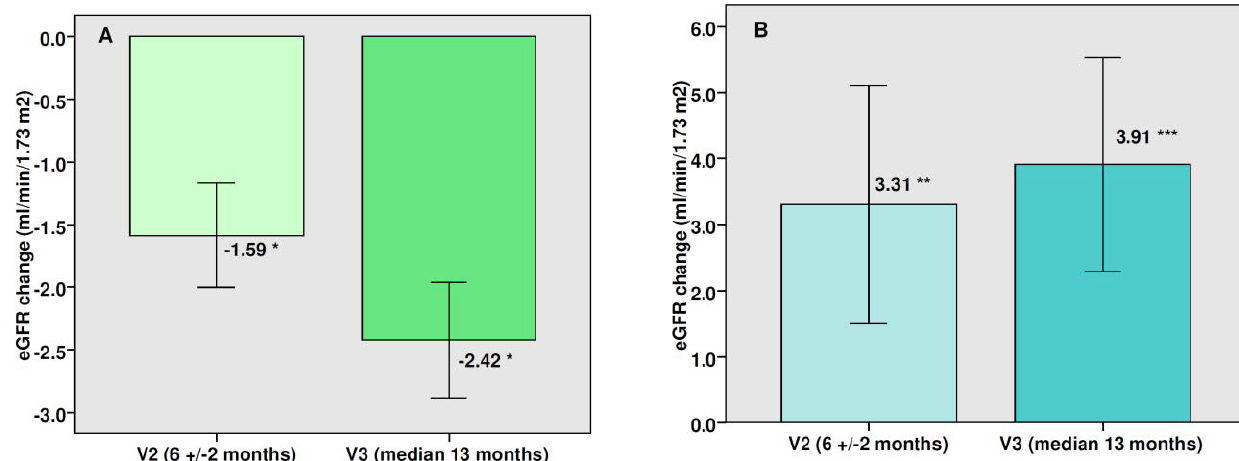
Figure 3. Changes in eGFR after therapy with canagliflozin in patients with baseline eGFR equal to or above 60 mL/min/1.73 m 2 (91.4%, mean baseline eGFR 88 mL/min/1.73 m 2 , panel ( A )) and in patients with baseline eGFR below 60 mL/min/1.73 m 2 (8.6%, mean baseline eGFR 53.5 mL/min/1.73 m 2 , panel ( B )). Bars: mean change ± SEM. * p < 0.0001 vs. baseline, ** p non-significant vs. baseline, *** p = 0.02 vs. baseline.